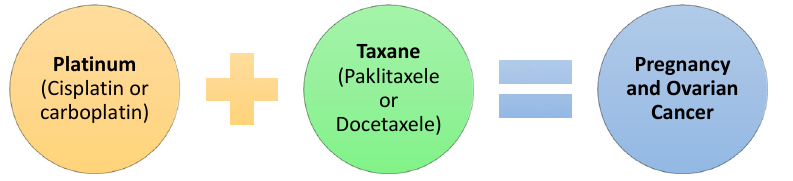
Figure 4. Pregnancy and Ovarian Cancer .